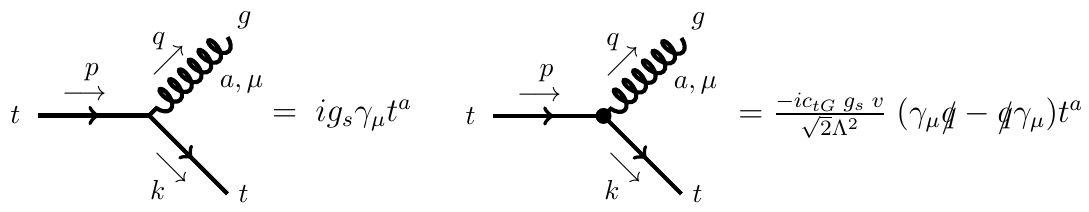
Figure 14 . Feynman rules for (left) the SM t - t - g vertex and (right) the anomalous t - t - g coupling originated from the O operator in eq. (3.1). tG